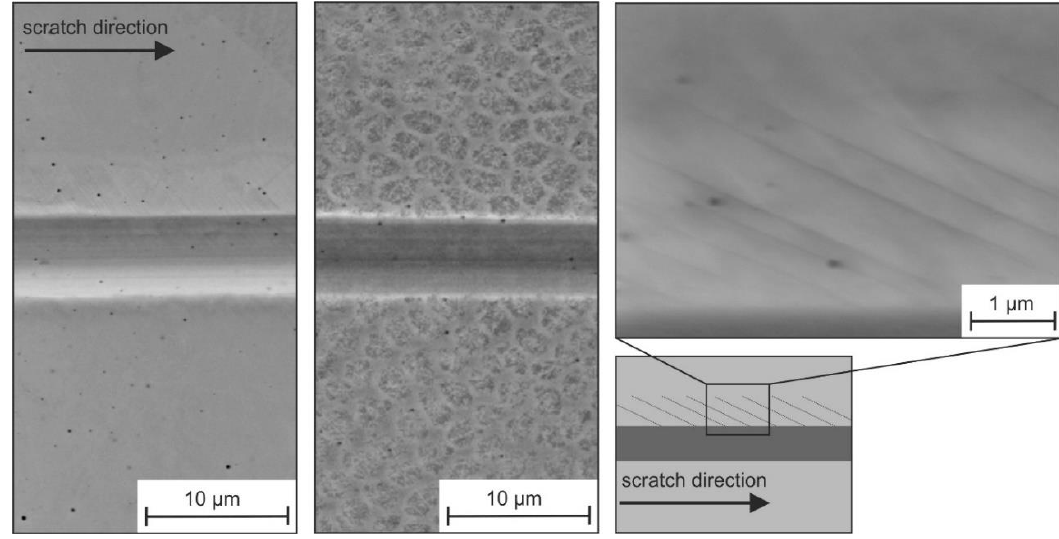
Figure 19. SEM images of a scratch groove in the LMD specimen.